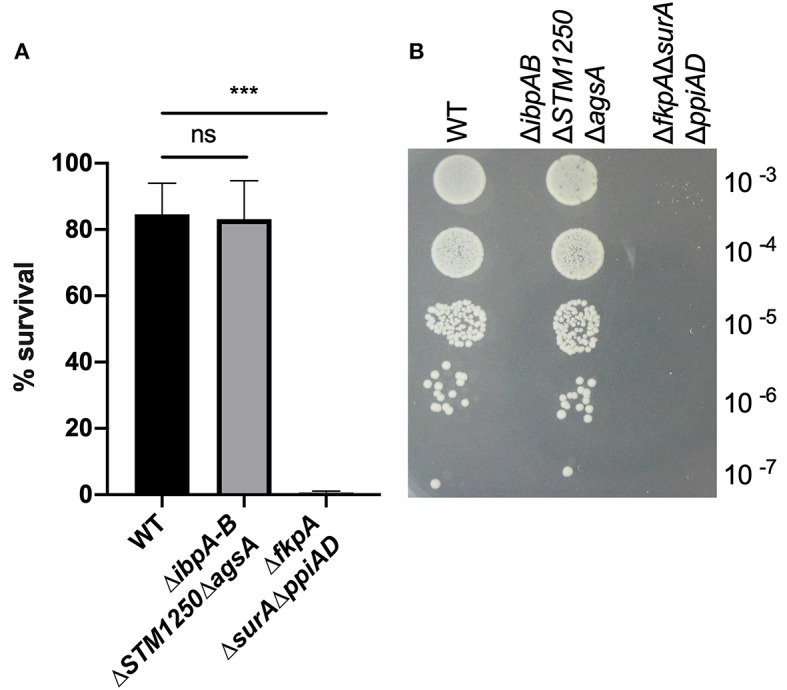
The quadruple deletion mutant is not sensitive to 65 μg/mL vancomycin. O/N cultures were serially diluted in PBS and 10 μL spotted onto LB agar either with or without 65 μg/mL vancomycin. (A) Colonies grown on vancomycin expressed as a percentage of colonies on LB agar. (B) Representative image of growth on vancomycin. Data are the means of three separate experiments performed in duplicate. Error bars show SEM. Data analyzed by one-way ANOVA with Tukey's multiple comparisons test, ***p < 0.0005.